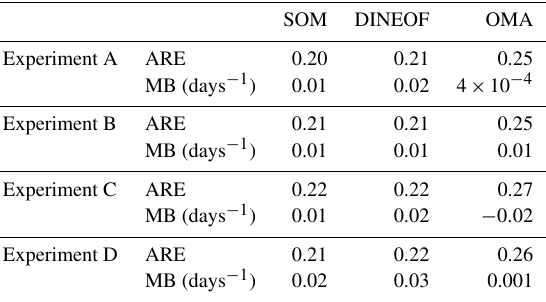
Table 3. Mean absolute relative error (ARE) and mean bias (MB) of the LCS obtained using reconstructed HFR velocities from the three methodologies with respect to the REF-LCS for the four ex-